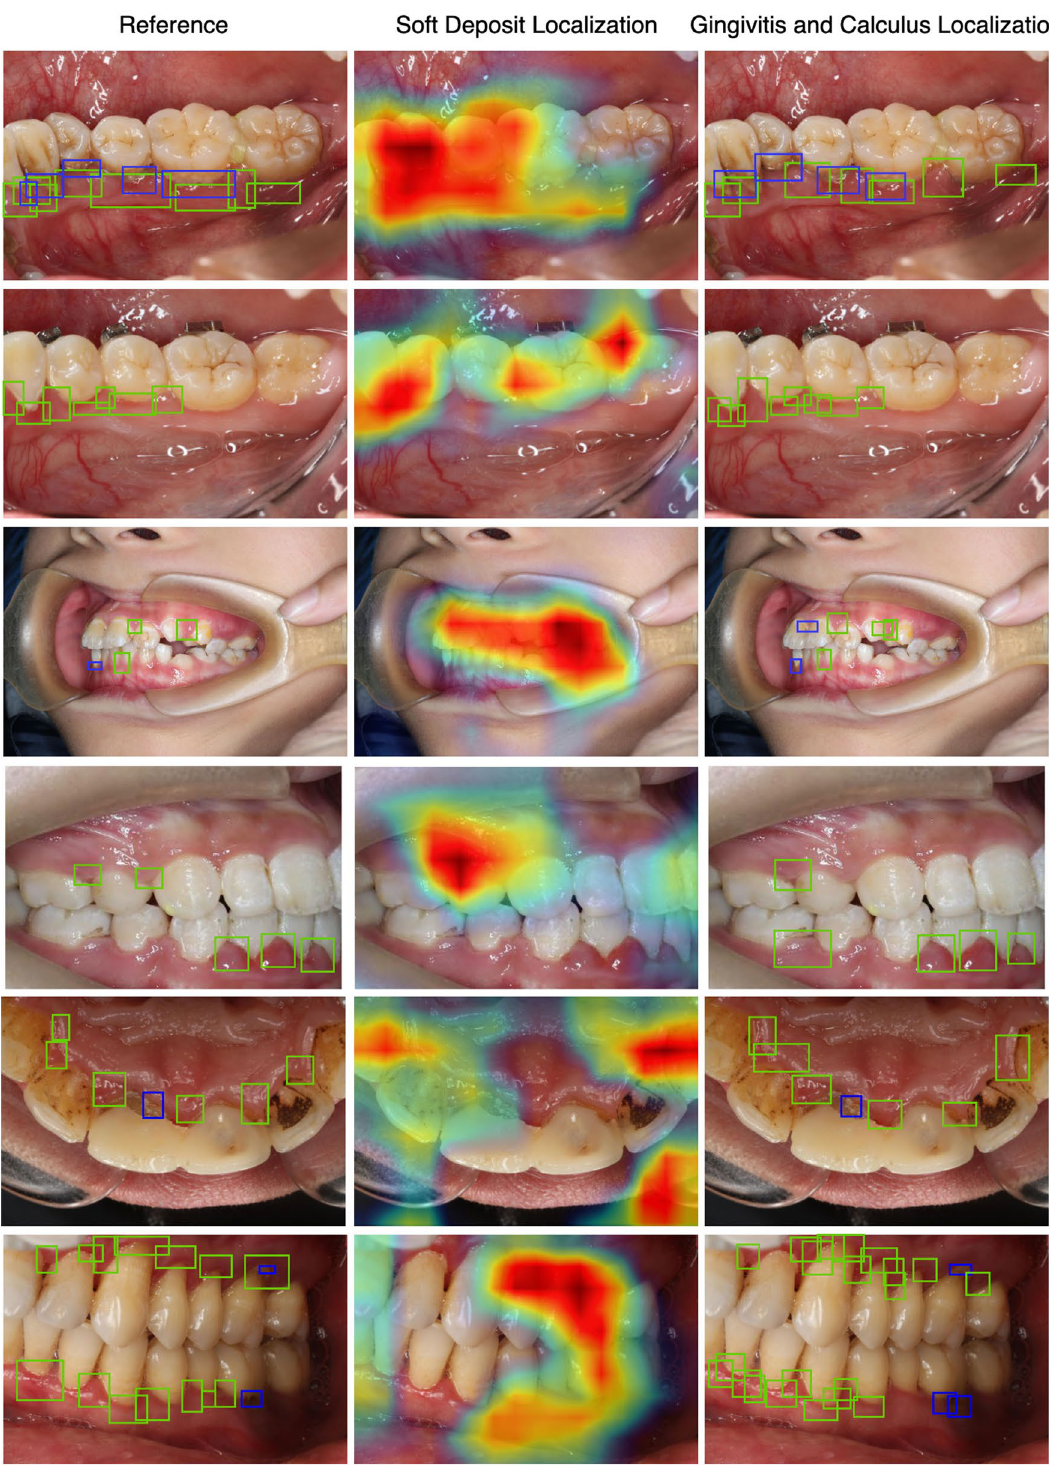
Figure 3. Examples of detection results on the testing data. Left: ground-truth annotations. Middle: Predicted locations of soft deposits represented with heat-map. Right: predicted locations of gingivitis and dental calculus represented with green and blue boxes,